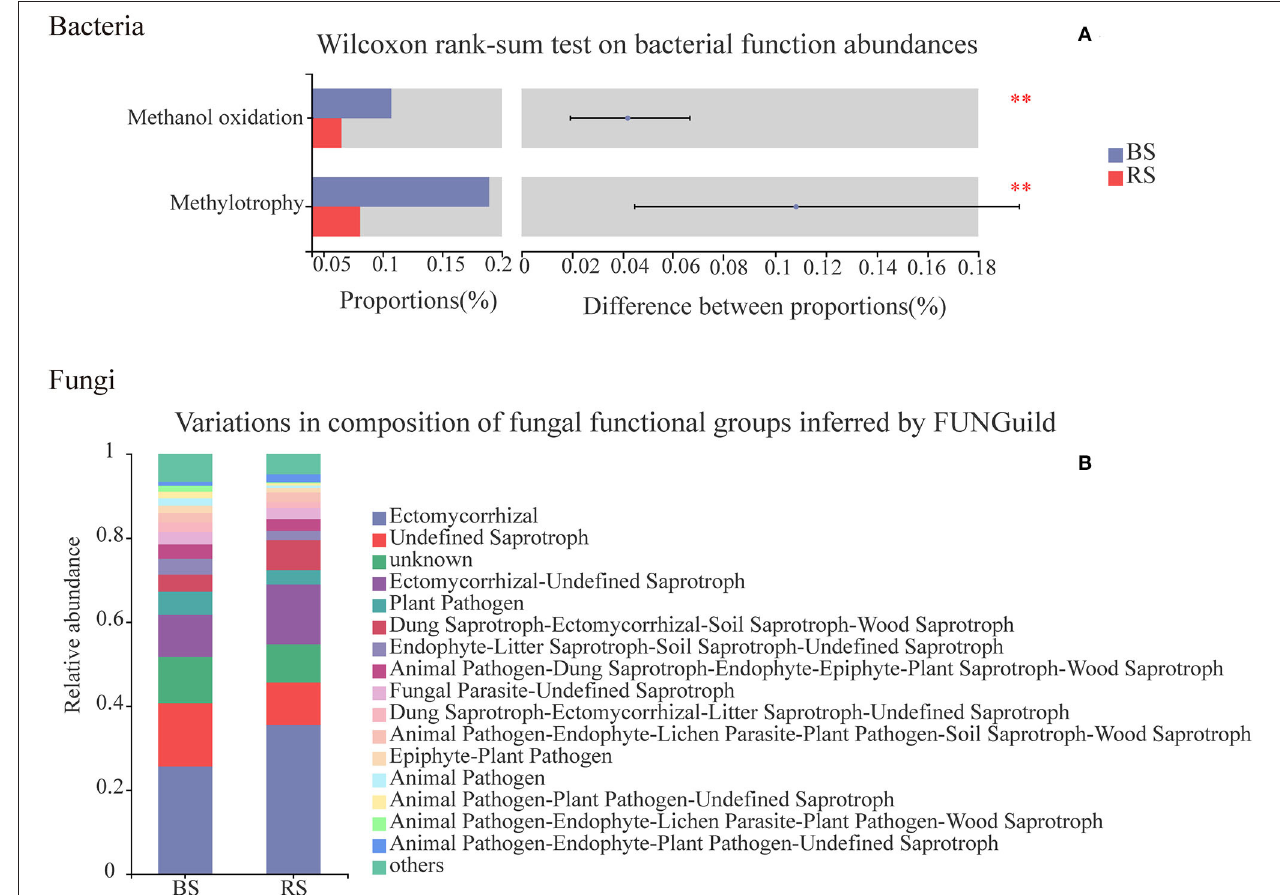
FIGURE 8 | Functional predictions of bacteria and fungi in the bulk soil and the rhizosphere soil. (A) Vertical axis, function names; horizontal axis, the percentage values of the functional abundances. Different colors indicate different groups. **Indicate p < 0.01. The top nine functional abundances are shown. (B) Vertical axis, the proportion of Guild’s abundance in different groups; horizontal axis, different